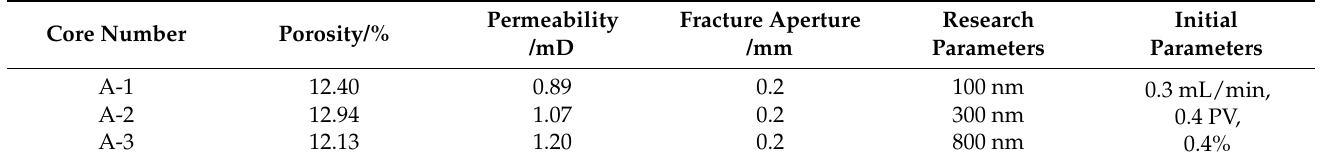
Table 6. Experimental schemes of nanospheres in low-permeability fractured